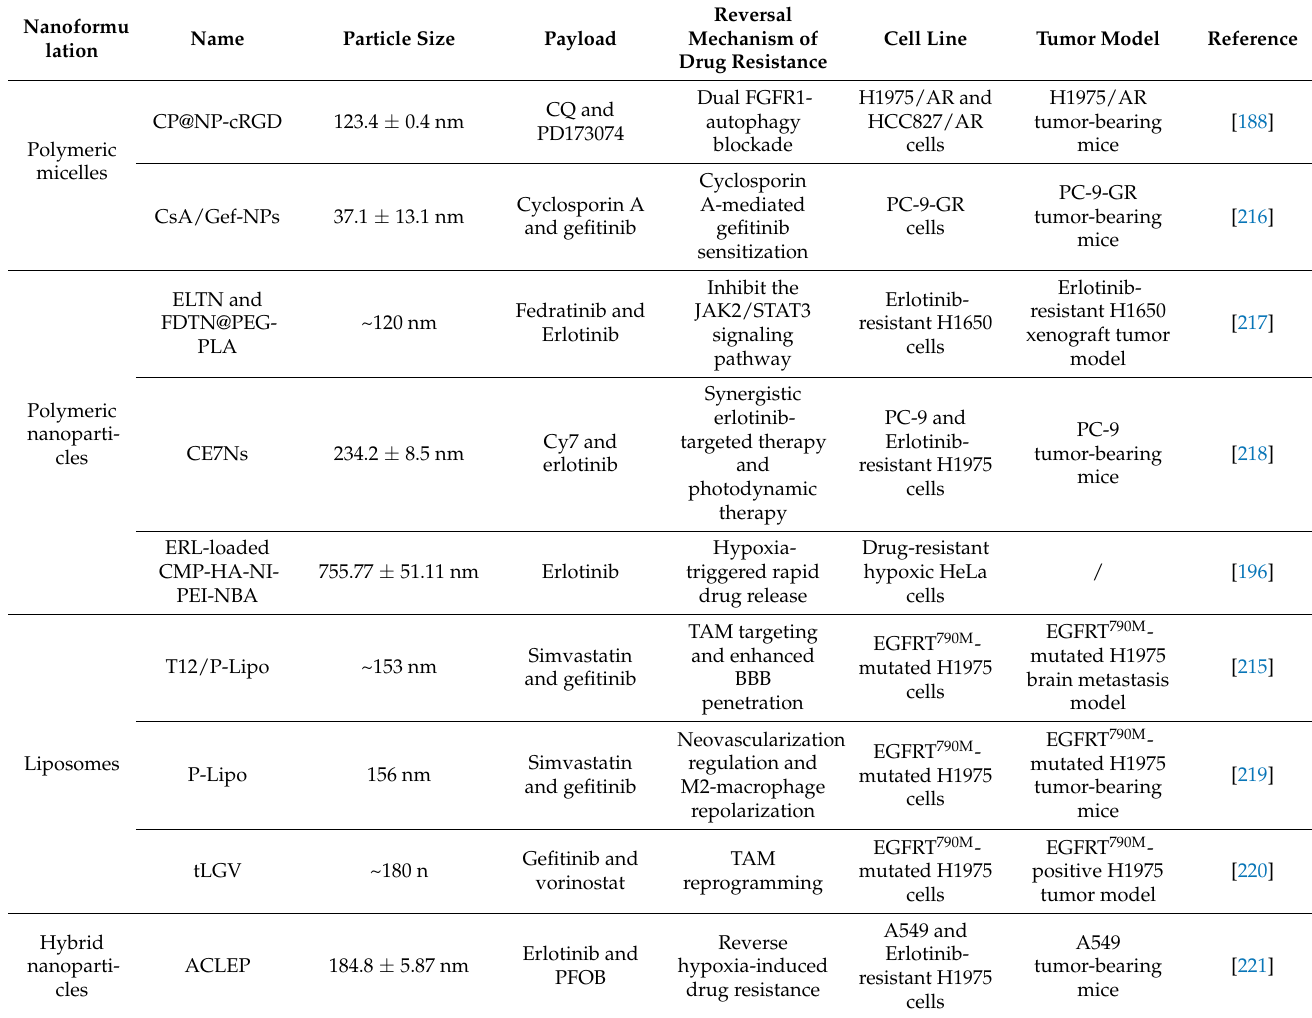
Table 3. Recent advances in nanomedicines for overcoming resistance to targeted